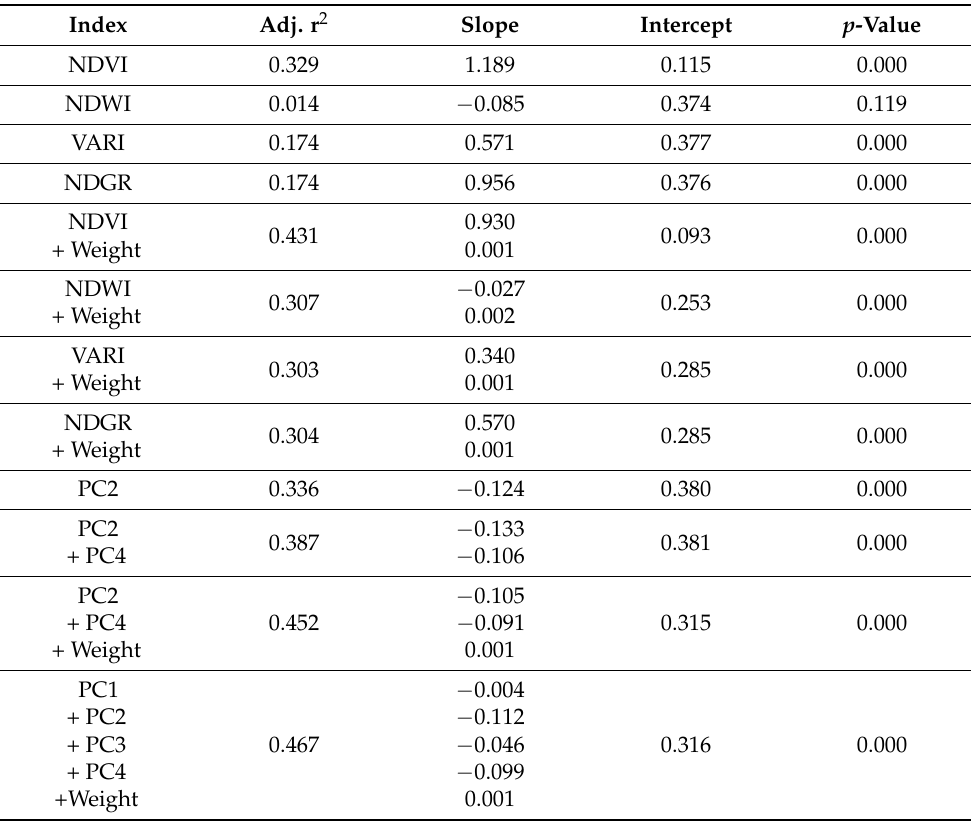
Table 4. Summary of Models Based on Vegetation Indices, PCs, and Total Sample Weight (in